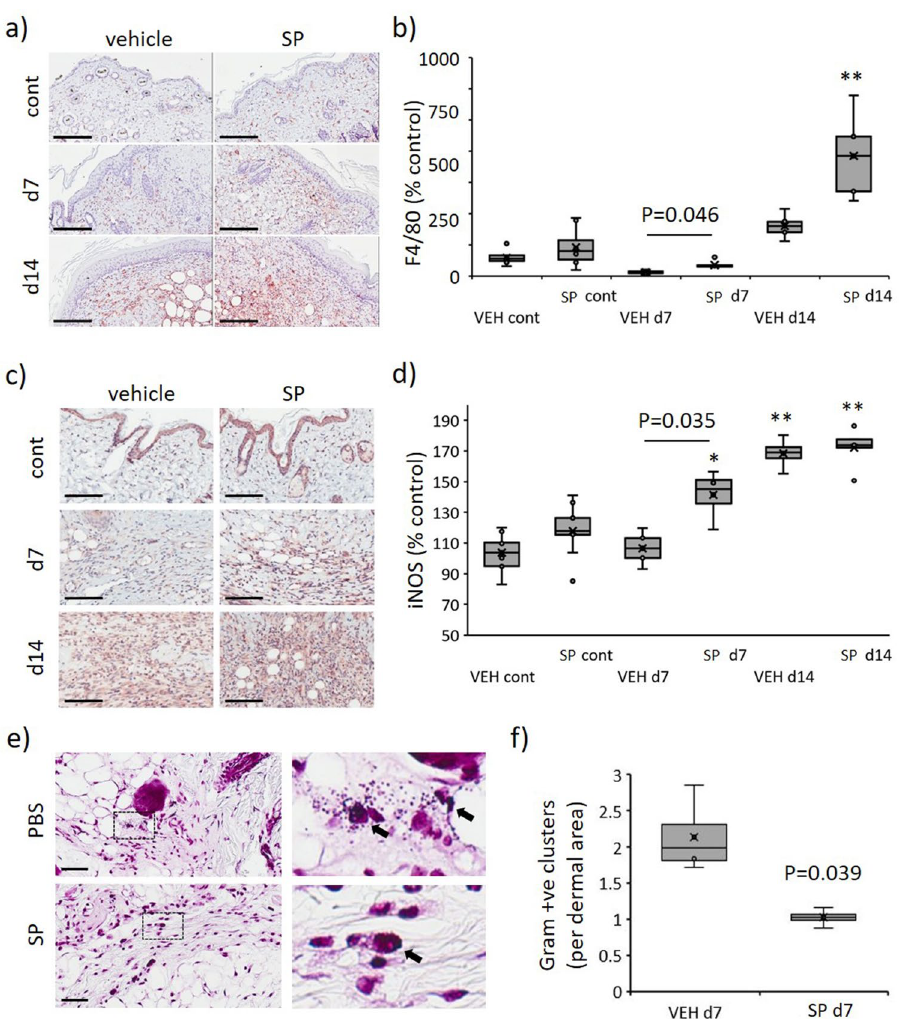
Figure 7. Increased macrophage recruitment and reduced bacterial load in SP-treated pressure injury. F4/80 representative images ( a ) and quantification ( b ) in mouse pressure injury. iNOS representative images ( c ) and quantification ( d ) in mouse pressure injury. Gram stain representative images, including high magnification panels ( e ), and quantification ( f ) in mouse pressure injury at d7 post-injury. Data in ( b , d , f ) presented as a box and whisker plot and analyzed by two-way ANOVA with Bonferonni post-hoc test (n = 6 per group). Data displayed as total staining intensity per unit area as a percentage of the unwounded vehicle-treated control ( b , d ) or number of bacterial colonies per unit area ( f ). * P < 0.05, ** P < 0.005. Scale bars = 200 µm ( a ), 80 µm ( c ) and 50 µm ( e